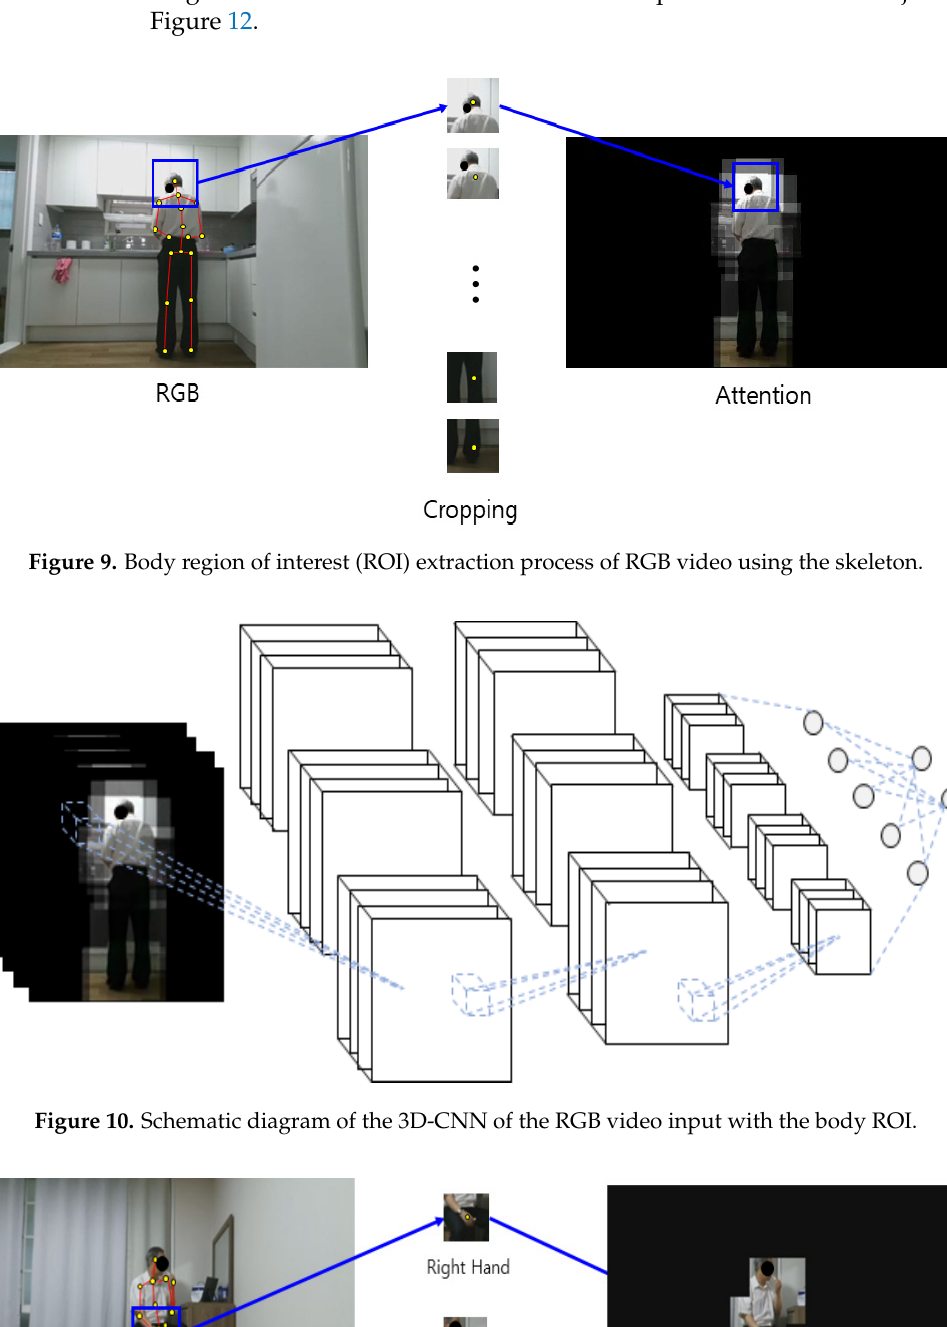
Figure 12. Schematic diagram of the 3D-CNN of RGB video input with the hand–object ROI. An ensemble of neural networks is a method to derive better results by combining the results of several individually trained models with one goal. Individual models focus on their respective features without distraction from different input data. Further, indi- vidual models can diversify data analysis strategies through different neural network structures. A better synergy effect is created through ensembled models of these various inputs and analysis strategies. A diagram of the ROI-based four-stream ensemble model for behavior recognition is shown in Figure 13. We used the commonly known addition and multiplication for the scores obtained from each stream in the ensemble deep learning